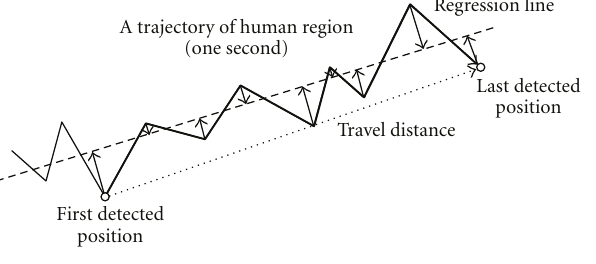
Figure 16: Features of a